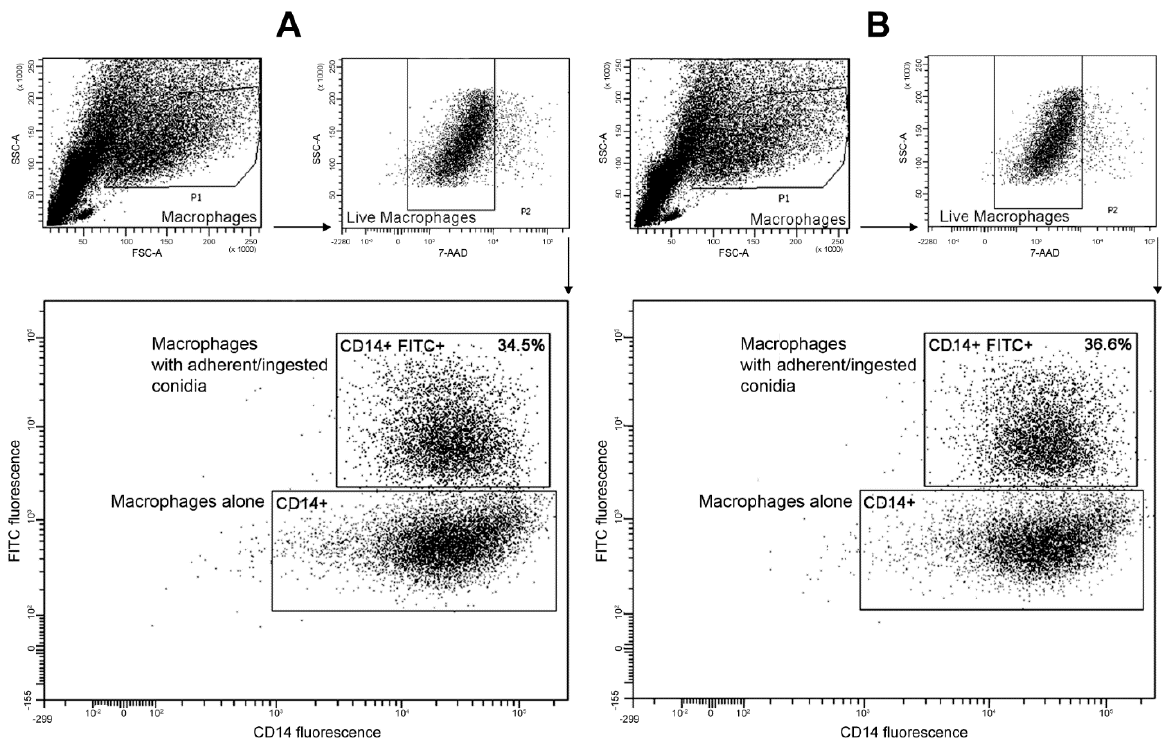
Figure 4. Flow cytometry analysis of macrophages ingesting conidia of SODD defective mutant ( KU70Δ/SODDΔ ) and its parent strain ( KU70Δ ) . After 6 h of incubation with fluorescein isothiocyanate (FITC)-labeled conidia, CD14-labeled macrophages were selected apart from non-phagocytosed conidia (P1 population) on the histogram plotting side scatter (SSC) against forward scatter (FSC). Macrophages were then gated on the 7-aminoactinomycin D (7-AAD) channel to select live macrophages (P2 population) before plotting the cells against the fluorescence intensity in the scatter of CD14 vs. FITC fluorescence. Non-labeled conidia (FITC negative), as well as non-labeled macrophages (CD14 negative), were run to define the baseline of positive signal (not shown). Macrophages alone were only CD14+ signals, while macrophages with adherent or ingested conidia showed double-positive signals (CD14+ FITC+). ( A ): plots corresponding to the parent strain KU70Δ . ( B ): plots corresponding to the double mutant KU70Δ/SODDΔ . The percentage of ingestion displayed for each double-positive population refers to the ratio between the number of macrophages with adherent and/or ingested conidia and the total number of macrophages × 100. Presented data are representative of three independent experiments.